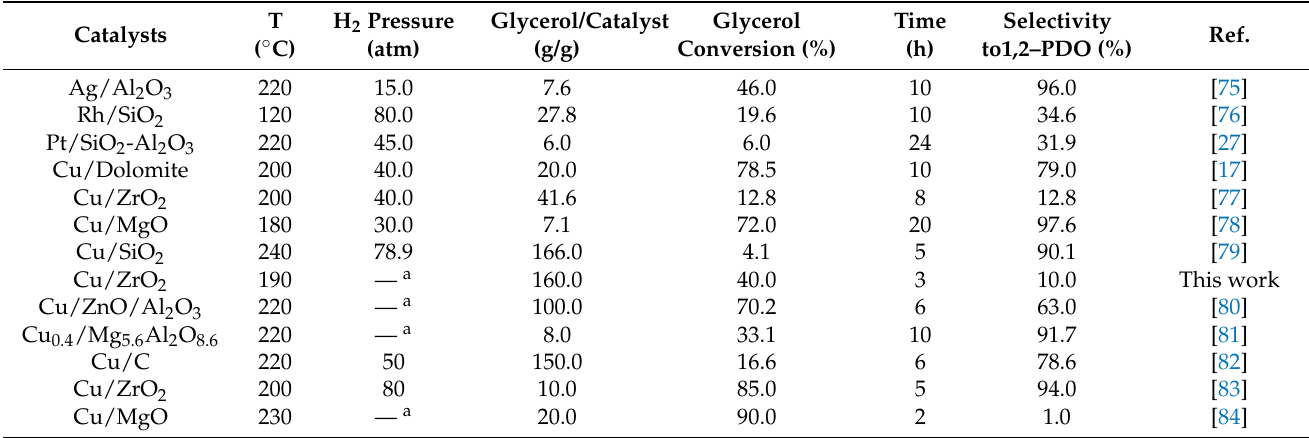
Table 6. Comparison of the results obtained in this work with other results from the literature in the liquid phase of catalytic valorization of glycerol over metal